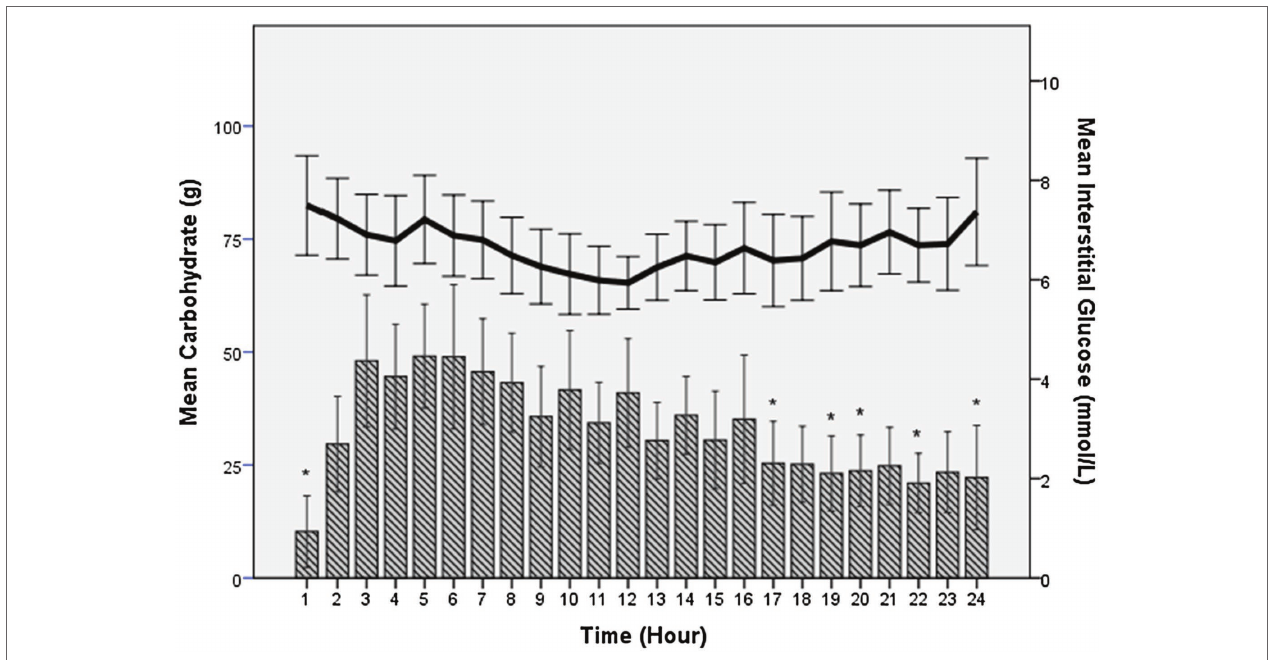
FIGURE 2 | Hourly mean interstitial glucose concentration (continuous line/right axis) and hourly mean carbohydrate (CHO) intake (bars/left axis) for participants during the G24 ultra-endurance race. Mean hourly CHO intake peaked at 49 ± 6 g in hour 5. *indicates significantly different hourly intakes to peak value. No significant differences were observed over time for mean interstitial glucose